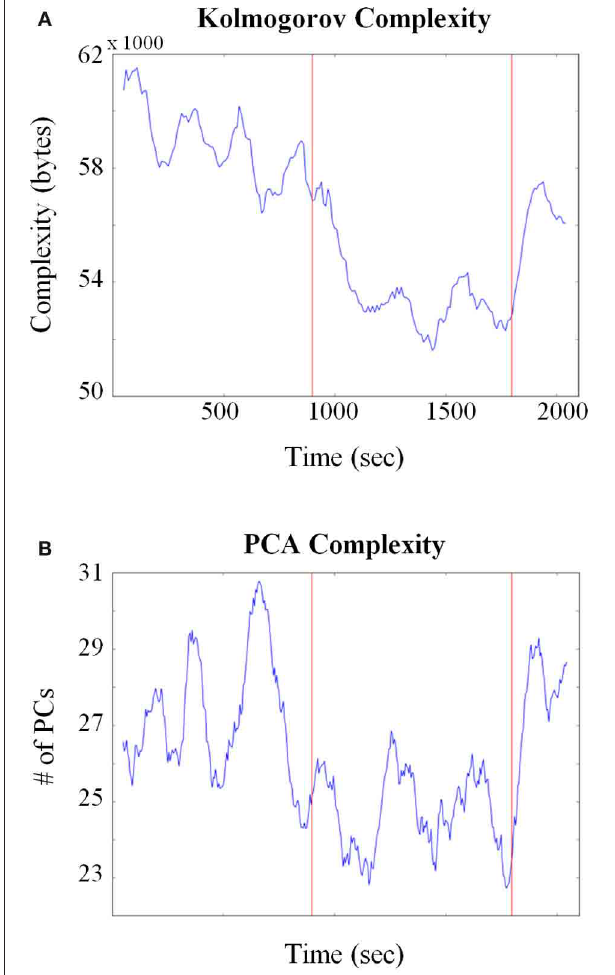
FIGURE 6 | Changes in entropy throughoutpellet drop sessions. (A) Entropy calculated from the posterior probabilities derived from a 7 state HMM for a single session. (B) Time series analysis indicating the moment at which entropy shifts, which corresponds to the moment of pellet drop onset. (C) Data from all sessions showing the average number of states with non-zero posterior probabilities (q) during the baseline period (red bars) and pellet drop period (green bars) as derived from HMMs with differing numbers of states (Q). The number of states was usually smaller for the pellet drop period than the baseline period. [ p < 0 . 05( ∗ ); p < 0 . 005( ∗∗ ); not significant (n.s.)].